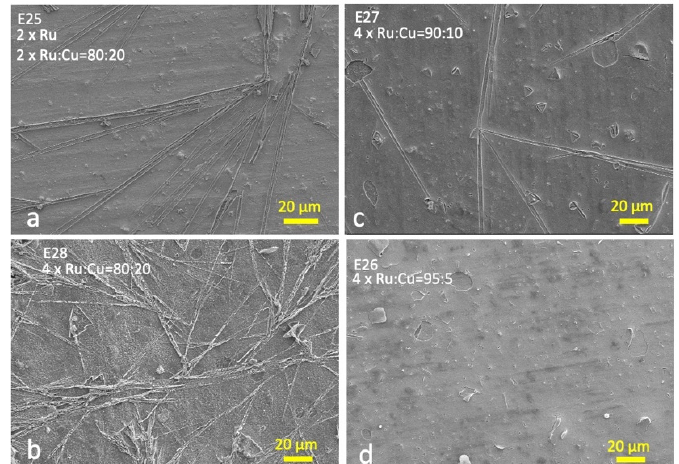
Figure 1. SEM microphotographs of: ( a ) electrode E4 (two layers of the Ru and two layers of the Ru:Cu = 80:20 mixture); ( b ) electrode E1 (four layers of the Ru:Cu = 80:20 mixture); ( c ) electrode E2 (four layers of the Ru:Cu = 90:10 mixture); ( d ) electrode E3 (four layers of the Ru:Cu = 95:5 mixture).